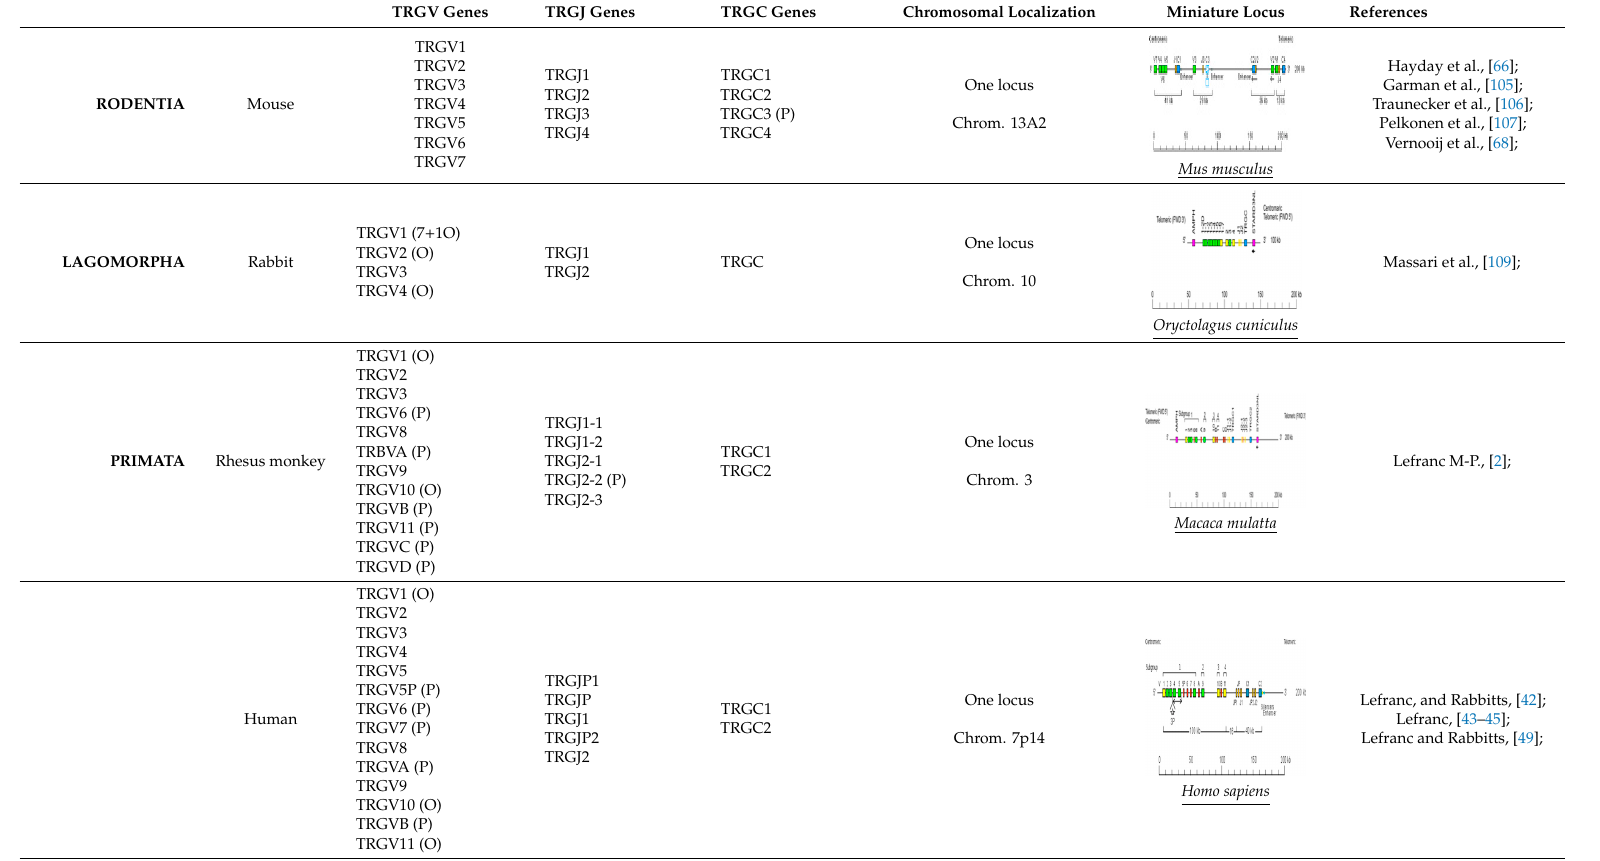
Legend: P = pseudogene, O =